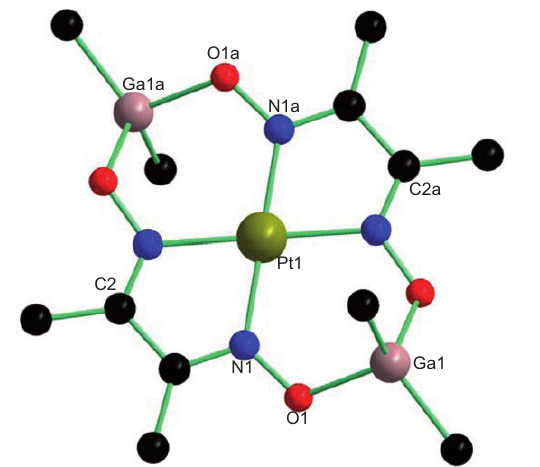
Figure 5 Structure of { Pt